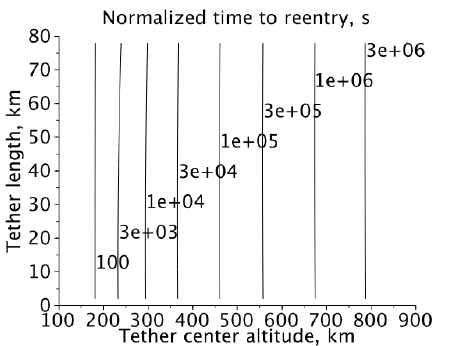
Figure 3. The normalized reentry time for tethers on equatorial circular